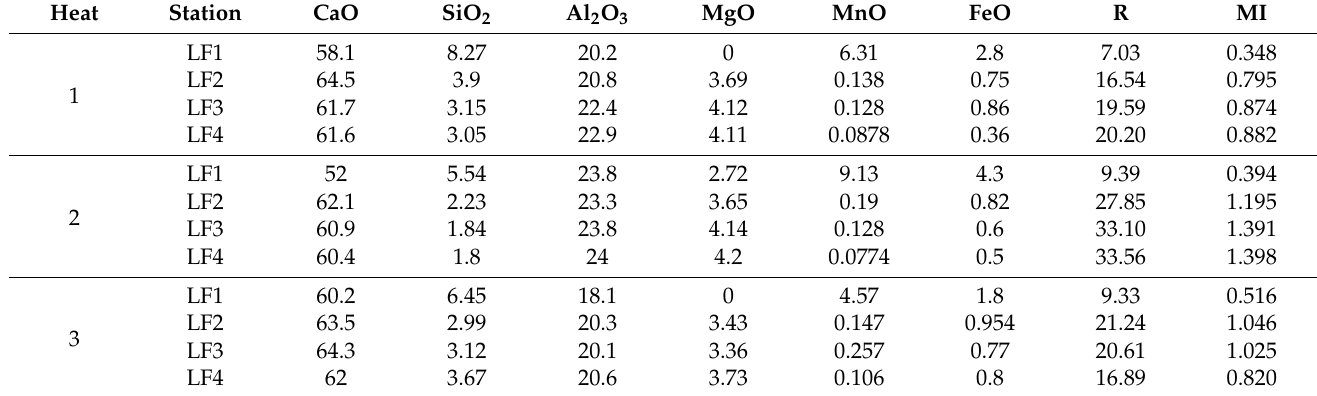
Table 3. Changes in the composition of the original refined slag series (wt%).